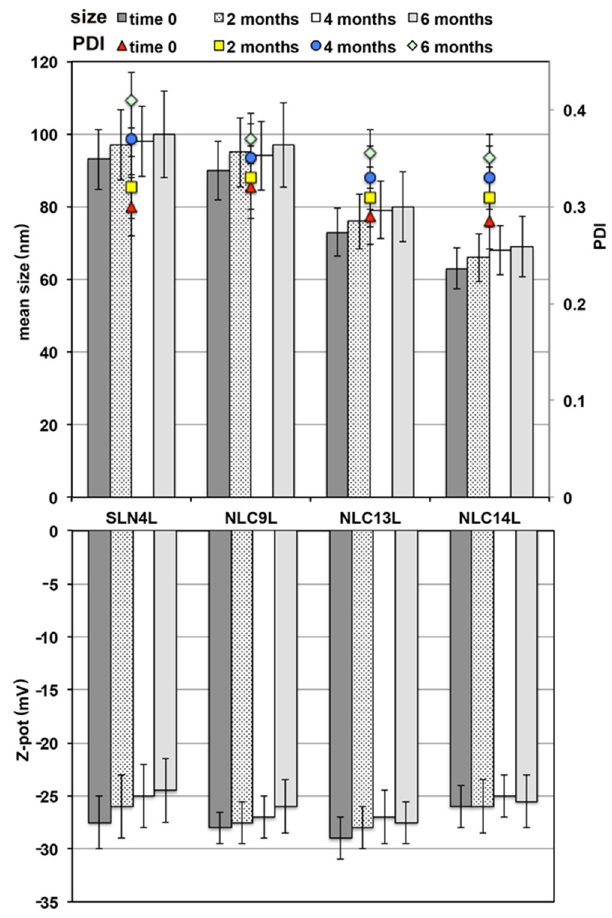
Figure 5. Effect of storage at 4 ± 1 °C on mean size, PDI and Zeta potential of the selected SLN and NLC formulations.